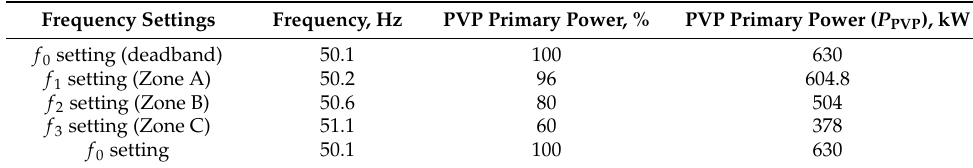
Table 1. PVP primary power for the frequency increase above 50.1 Hz.